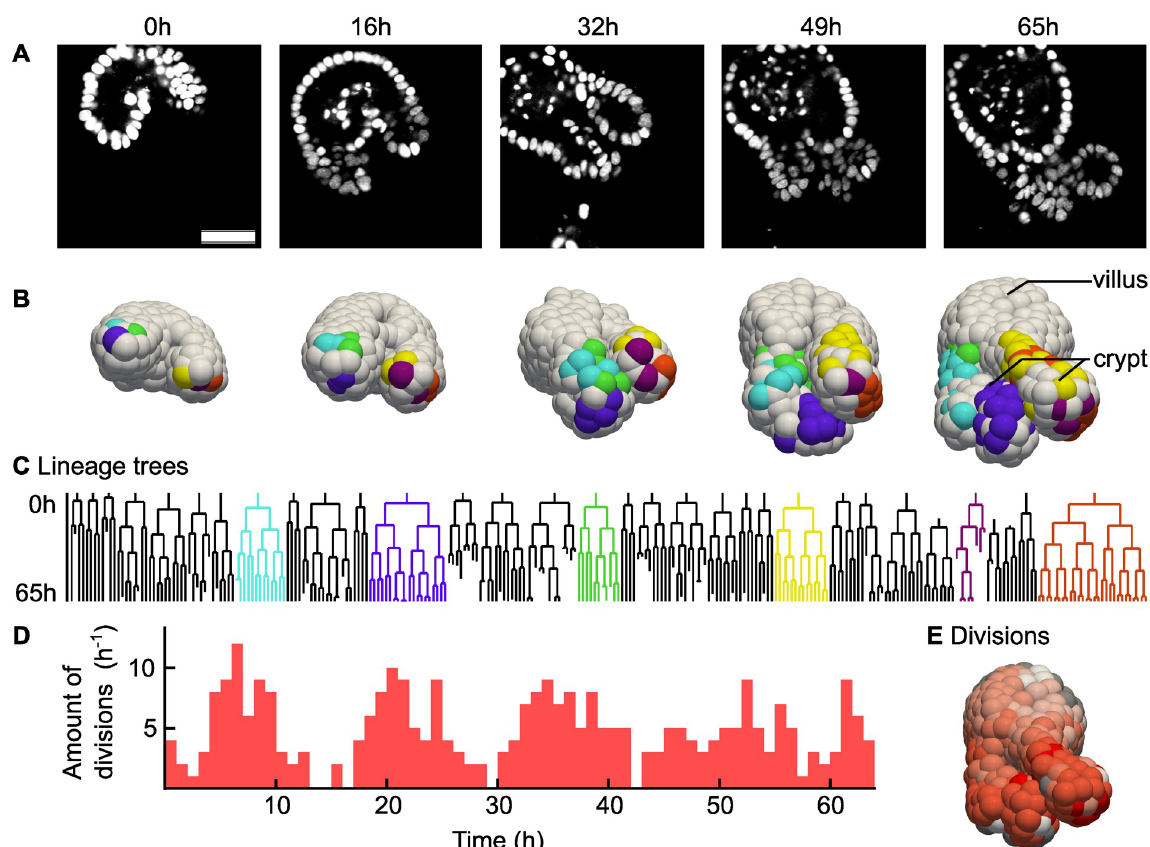
Fig 5. Analysis of a fully tracked organoid. ( A ) Single microscopy image slices of an intestinal organoid from a time lapse movie of 65 hours, in steps of 16.25 hours. H2B-mCherry was used to visualize the nuclei. Scale bar is 40 μ m.( B ) Digital reconstruction of the same organoid as in Panel a. Cells of the same color originate from the same cell at the beginning of the experiment. ( C ) Selected lineage trees. The colors match the colors in the reconstruction from Panel b. ( D ) Number of cellular divisions over time in a single organoid. ( E ) Number of times each cell divided during the time-lapse integrated over time, from 0 (white) to 5 (red). For gray cells, we could not count the amount of divisions because the cell was outside the image at an earlier point in time.